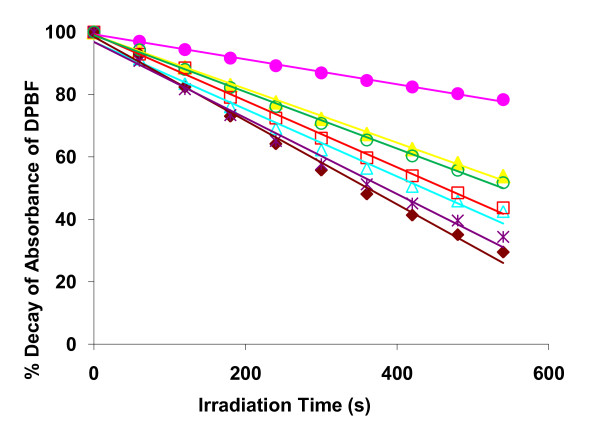
Photodecomposition of DPBF. Photodecomposition of DPBF in DMF/H2O (9:1) by singlet oxygen generated by the photosensitizers after irradiation with white light filtered through a cut-off filter for wavelengths < 540 nm (9 mW cm-2). Tetra-Py+-Me (pink filled circle), Tri-Py+-Me-PF (yellow filled triangle), Tri-Py+-Me-CO2Me (light blue open triangle), Tri-Py+-Me-CO2H (red open square), Di-Py+-Me-Di-CO2H opp (brown filled diamond), Di-Py+-Me-Di-CO2H adj (violet star), Mono-Py+-Me-Tri-CO2H (green open circle).